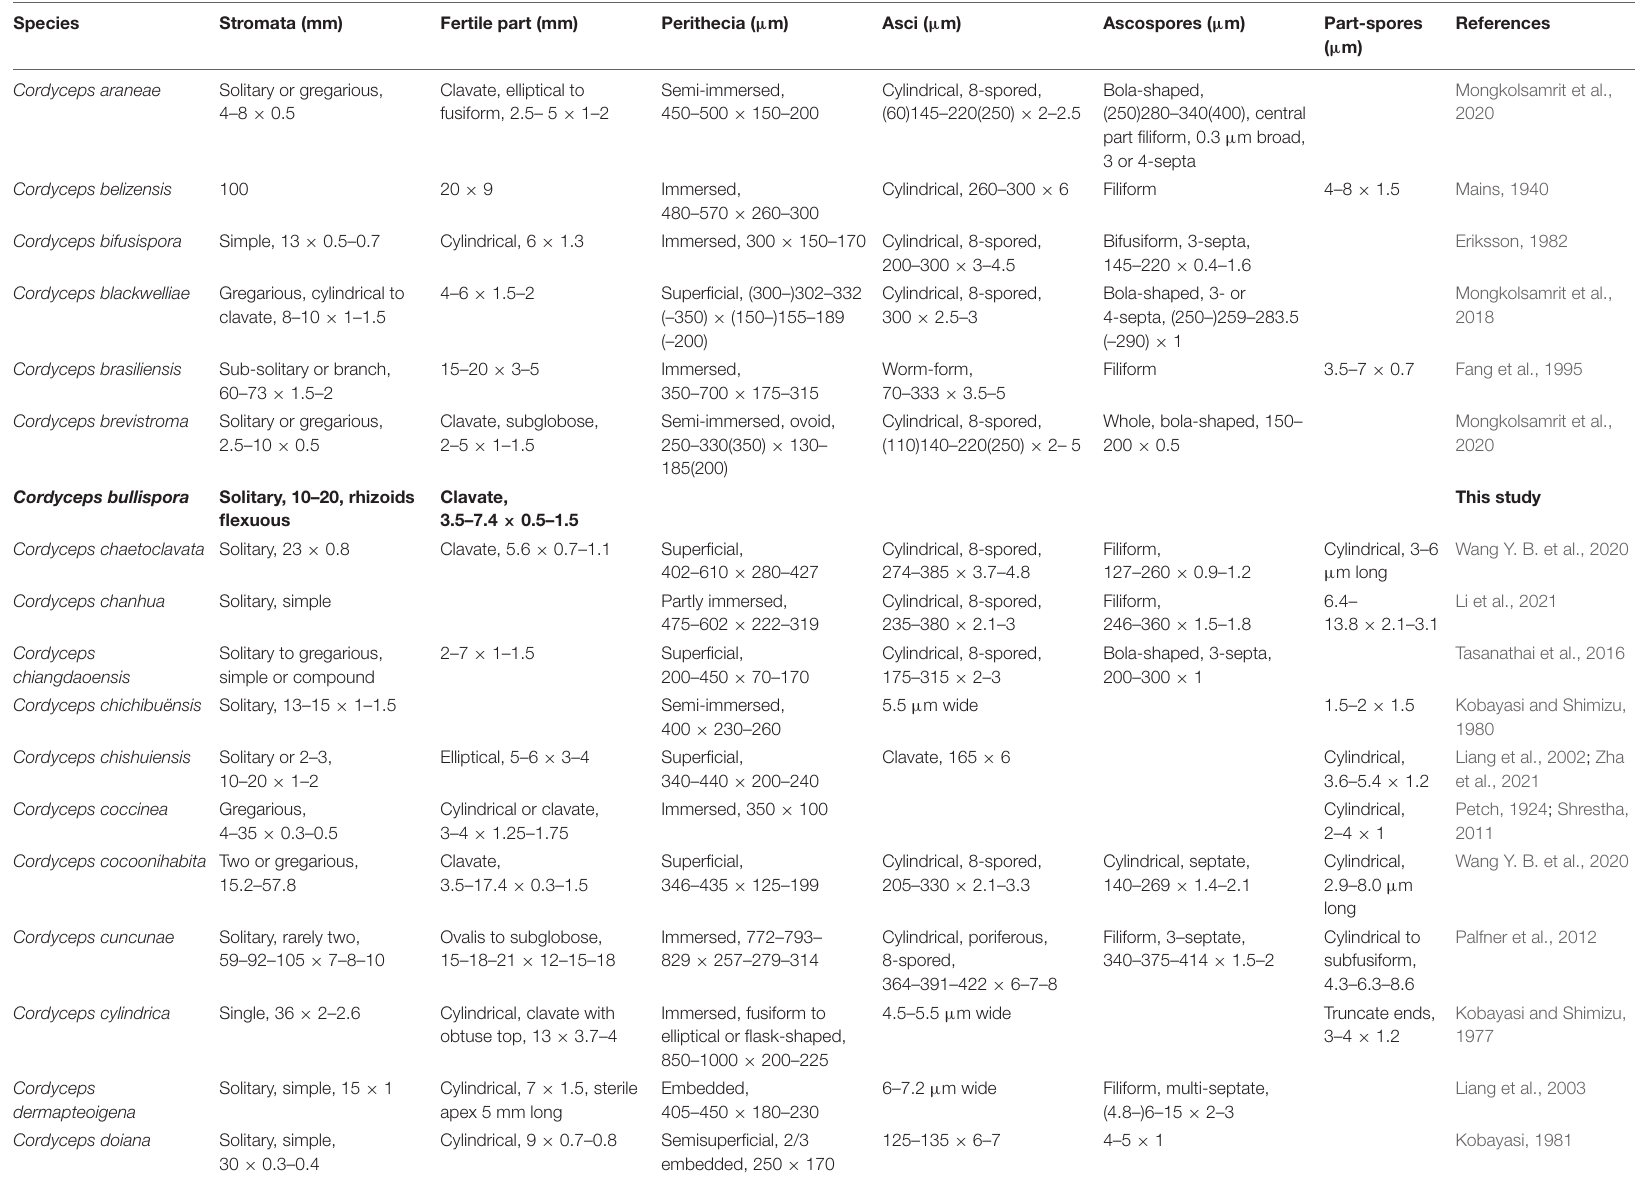
TABLE 2 | Comparison between the sexual morphs in